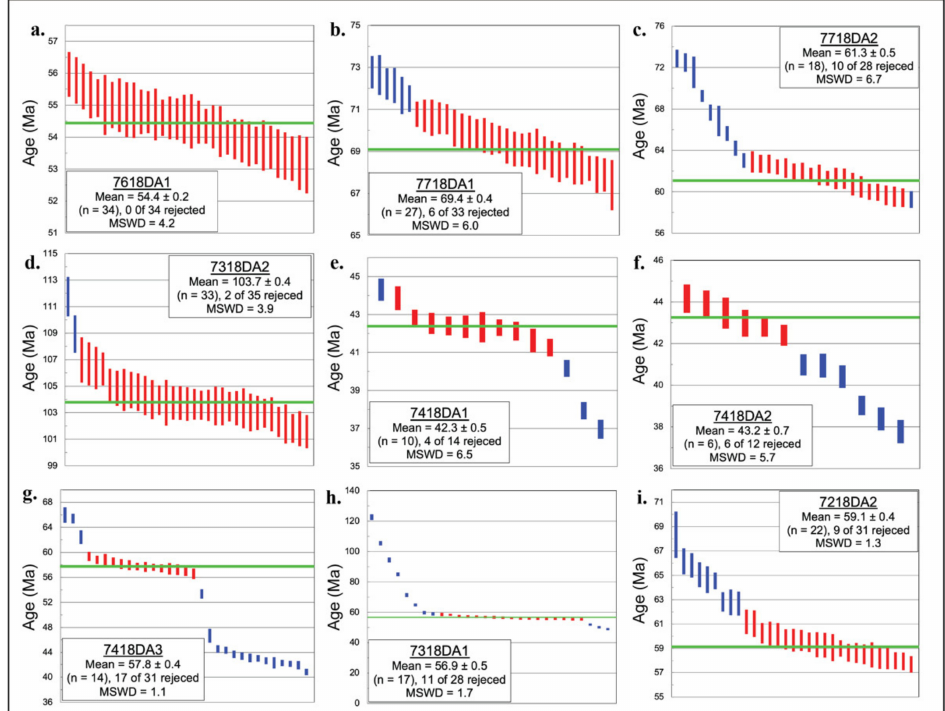
Figure 4. Zircon U-Pb geochronology weighted-mean age results by sample ( a – i ). Ages were calculated using the TuffZirc algorithm [82] from the Berkley Geochronology Center’s ISOPLOT program [83]. Box heights are 2 σ . Panels in the lower left of each graph display sample name, weighted-average crystallization age, sample size, and MSWD (mean square weighted deviate). Complete zircon U-Pb Geochronology results for individual grains can be found in Supplementary Table